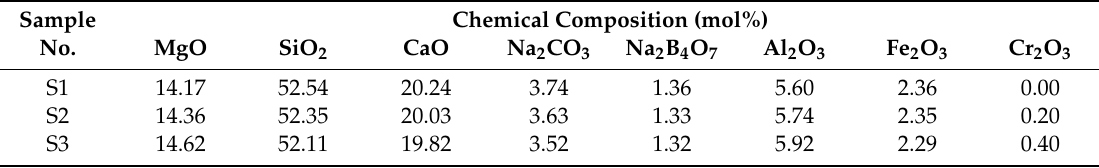
Table 1. Chemical composition of basic